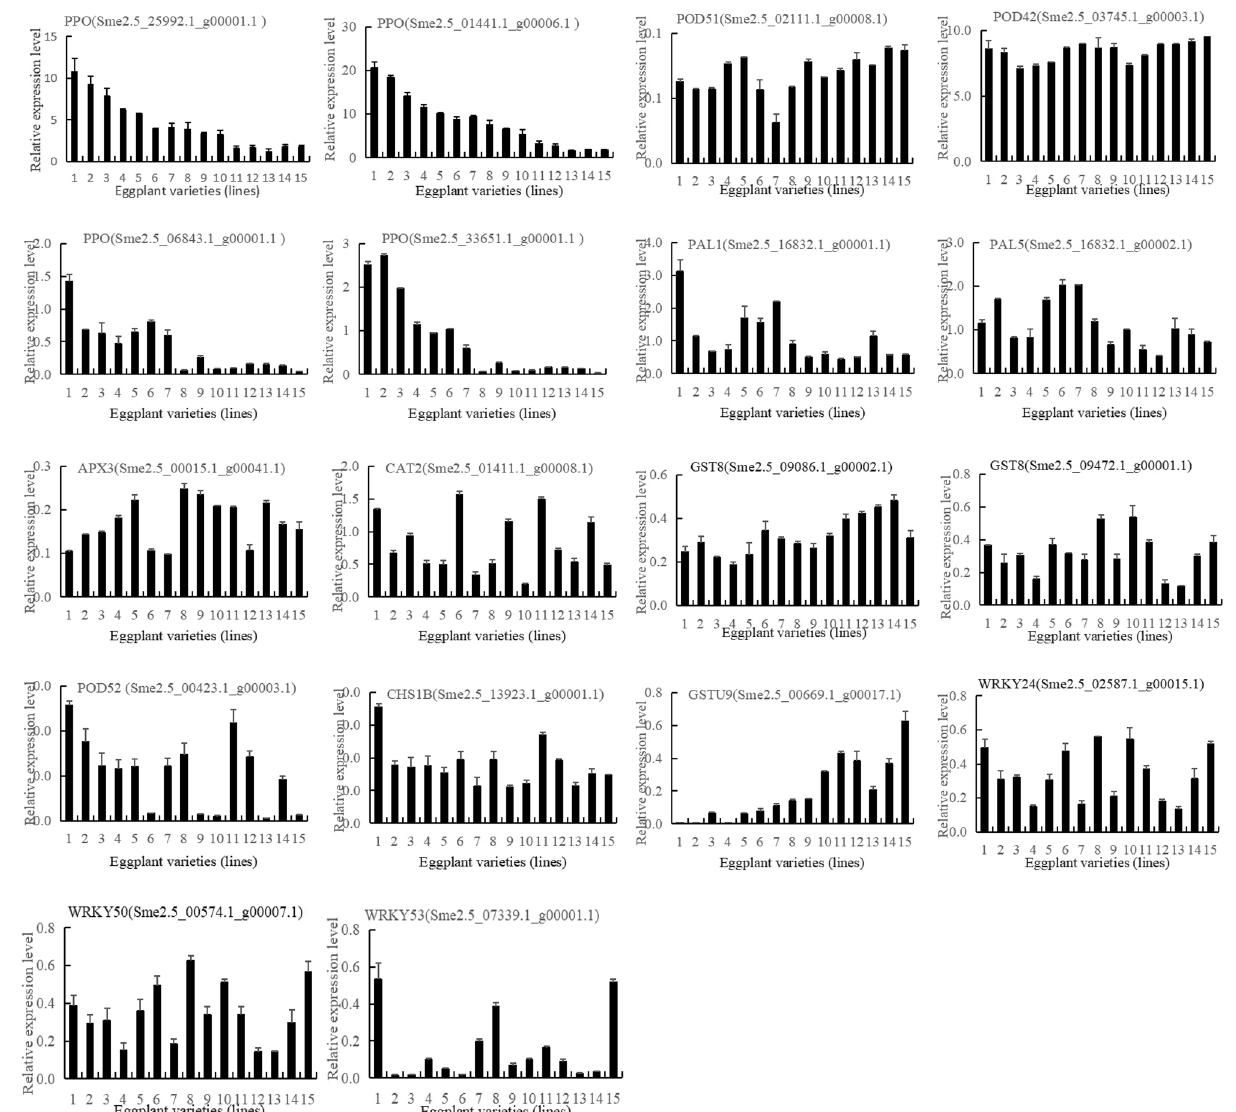
Figure 12. qRT-PCR of the expression levels of 18 browning-related genes in 15 eggplant materials with different browning